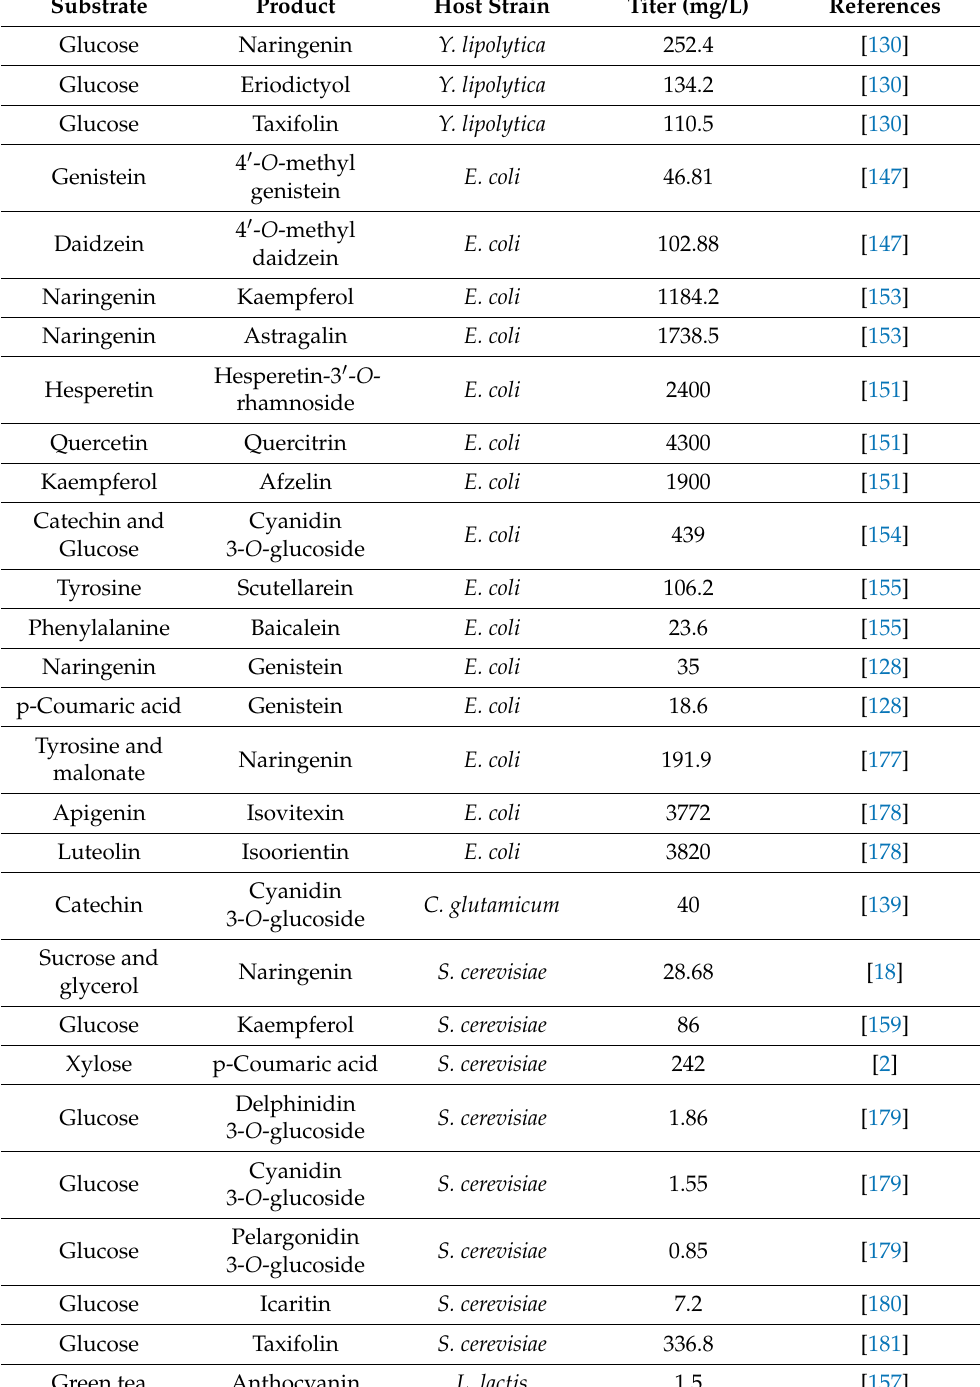
Table 4. Mono-culture approach for the microbial production of